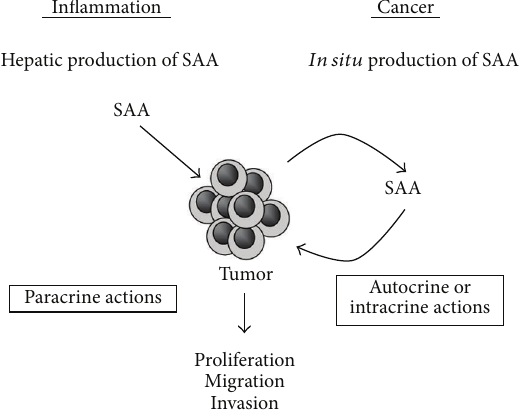
Figure 7: Influence of SAA on tumor cells. Glioma cells may be affected by SAA produced by the liver during inflammatory processes (paracrine actions) and by SAA synthesized by the tumor itself (autocrine or intracrine actions). The effect on glioma cell line proliferation, migration, and invasion depends on cell type and concentration of